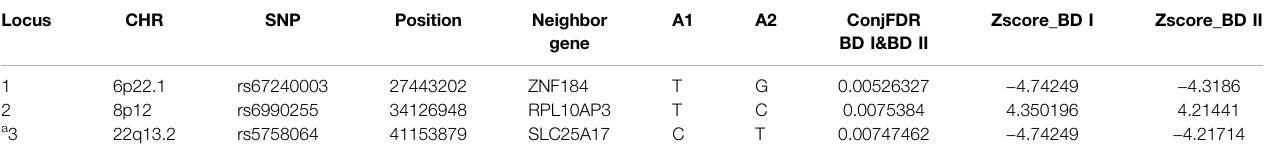
TABLE 1 | Conjunction FDR; pleiotropic loci in BD type I (BD I) and BD type II (BD II) (BD I & BD II) at conjFDR < 0.01. Locus